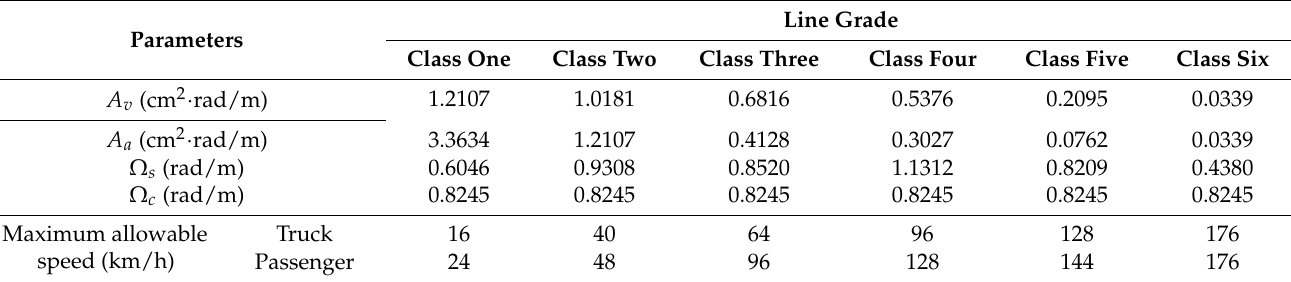
Table 6. US AAR orbital spectral parameters.